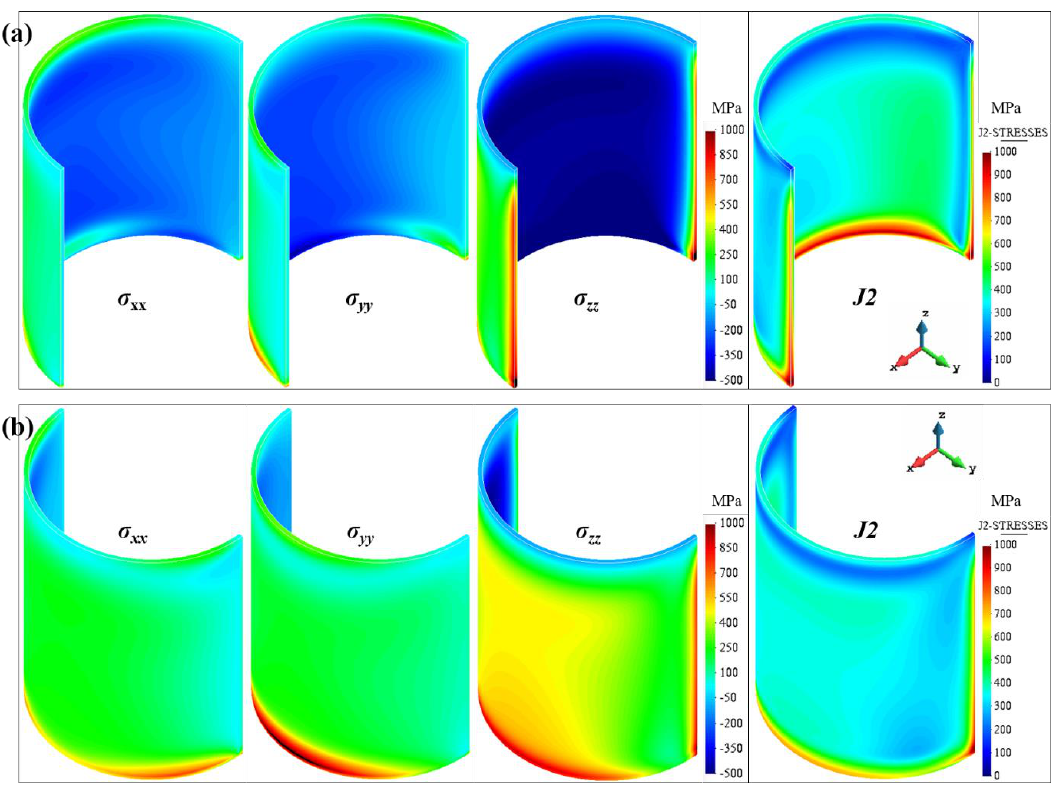
Figure 9. Residual stresses in three orthogonal directions and von Mises stress fields: ( a ) semi-cylin- drical (SC1) part; ( b ) semi − cylindrical (SC2) part.